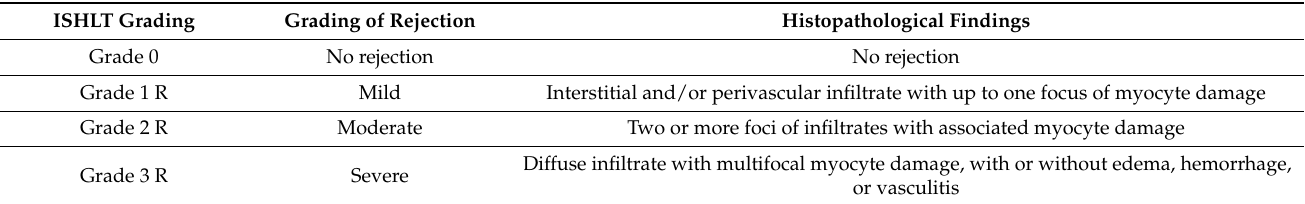
Table 1. International Society Heart and Lung Transplantation (ISHLT) grading of acute cellular rejection. ISHLT